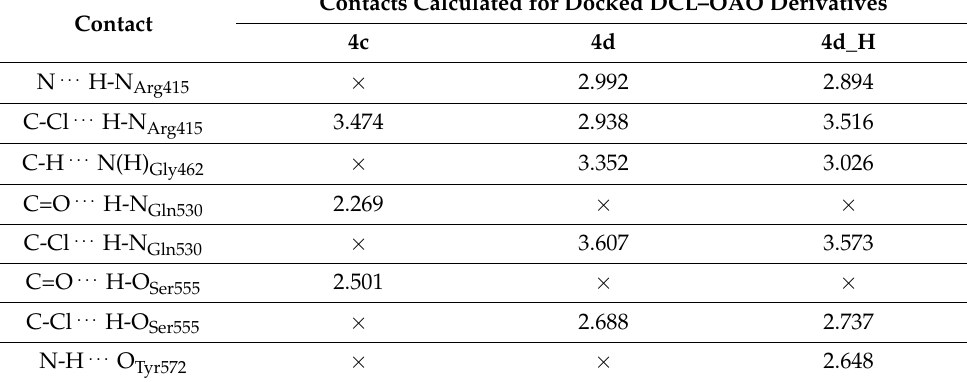
Figure 5. The first poses of the examined ligands (( A ) 4c , ( B ) 4d , and ( C ) protonated 4d ) were determined by the Chimera 1.13.1 package. ( D ) The superimposition of the docked DCL–OAO derivative conjugates (first poses). Table 3. Ligand-amino acid contacts (under d ≤ 4.0 Å) for the first poses of the DCL–OAO derivative conjugates generated during the docking